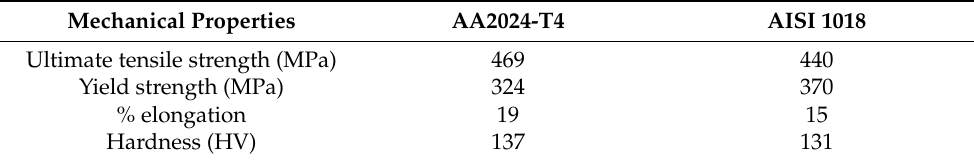
Table 2. The standard mechanical properties of AA2024-T4 and AISI 1018 base materials, data from